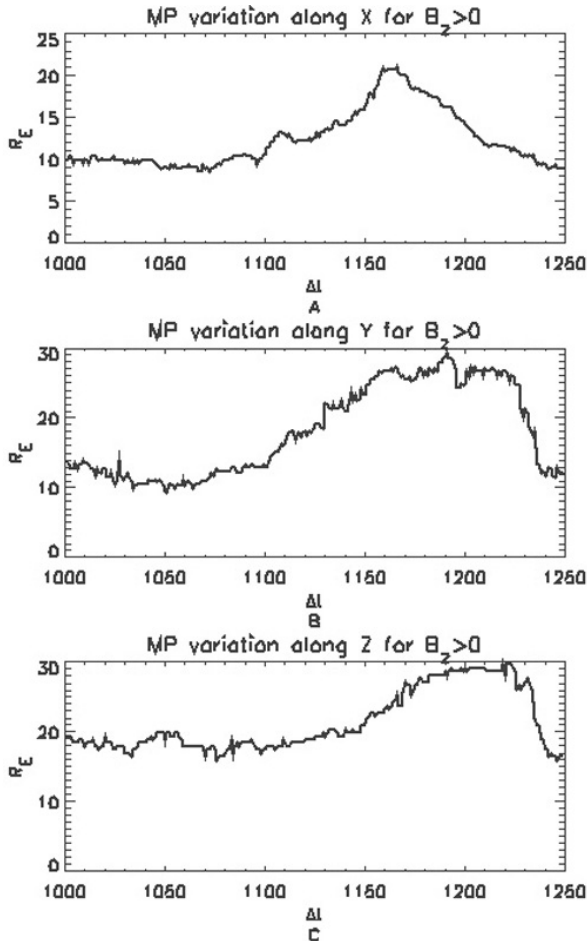
Fig. 6. Magnetopause’s size expansion measured from Earth loca- tion [ x = 60, y = 52, z = 53] R E along x, y and z-axis for B z > 0 are shown in panels (a) , (b) , and (c) ,